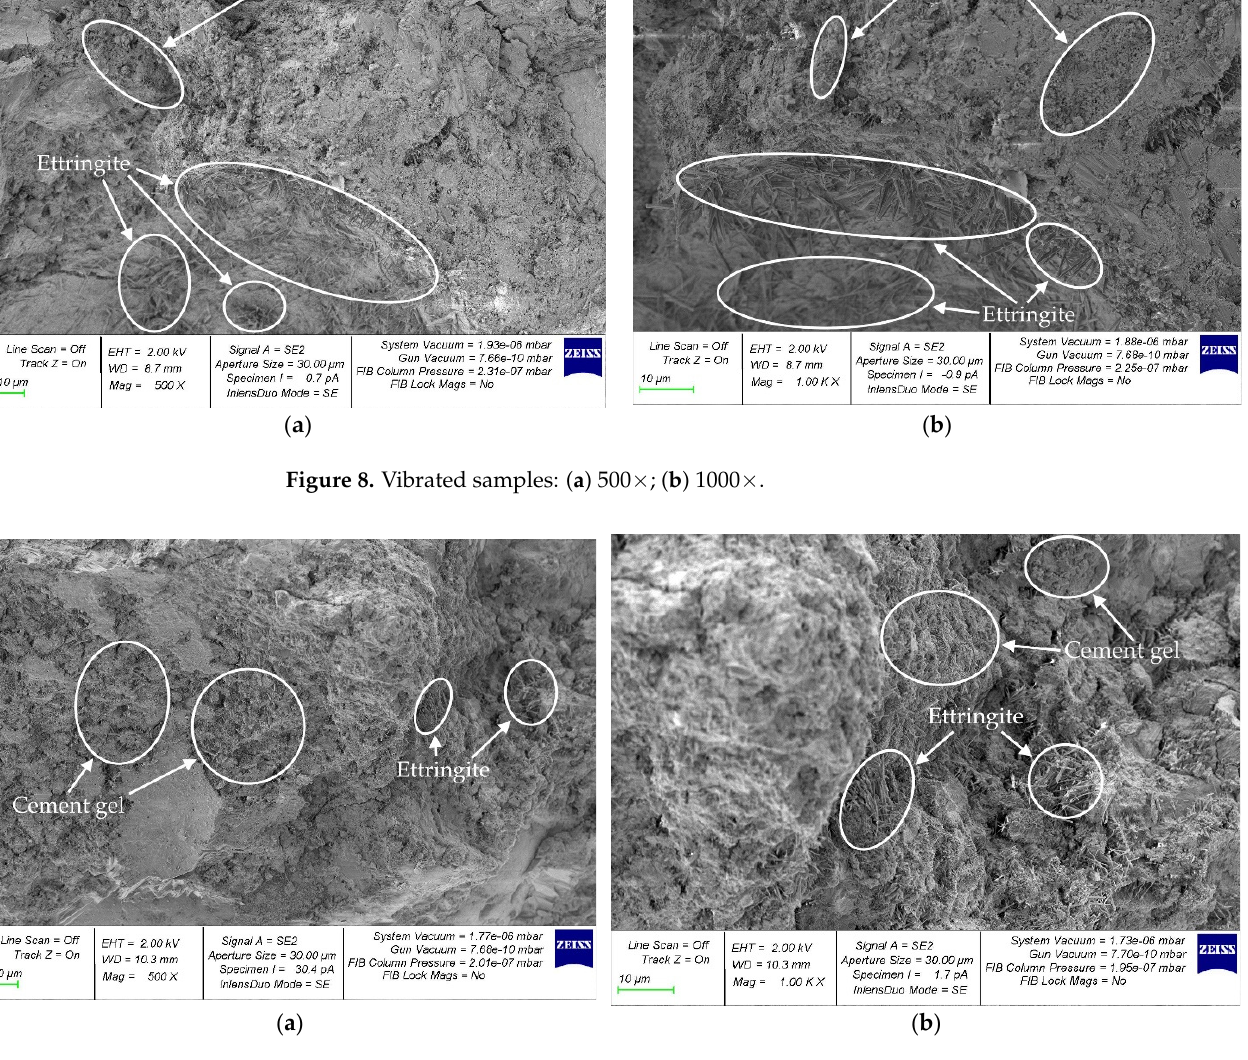
Figure 9. Centrifuged samples: ( a ) 500×; ( b ) 1000×.